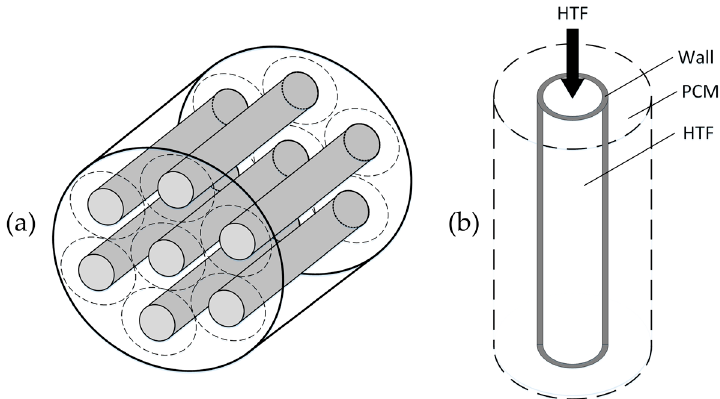
Figure 1. ( a ) shell-and-tube latent thermal energy storage (LTS) and ( b ) single storage element. HTF: heat transfer fluid; and PCM: phase change material.